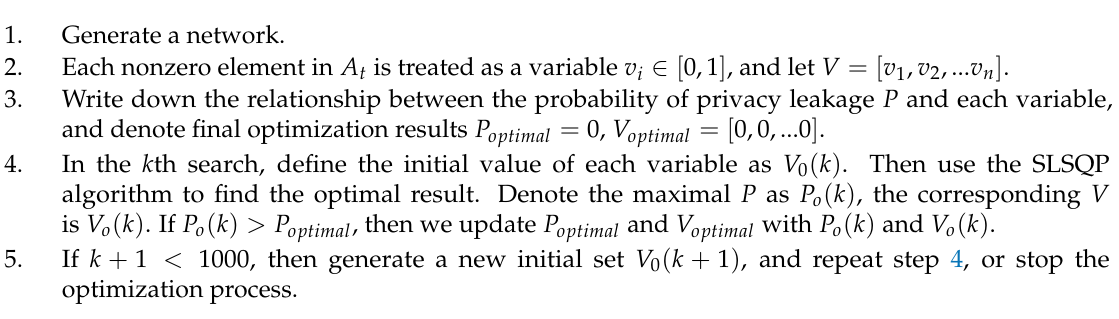
Algorithm 1 Suboptimal attacking strategy in arbitrary network